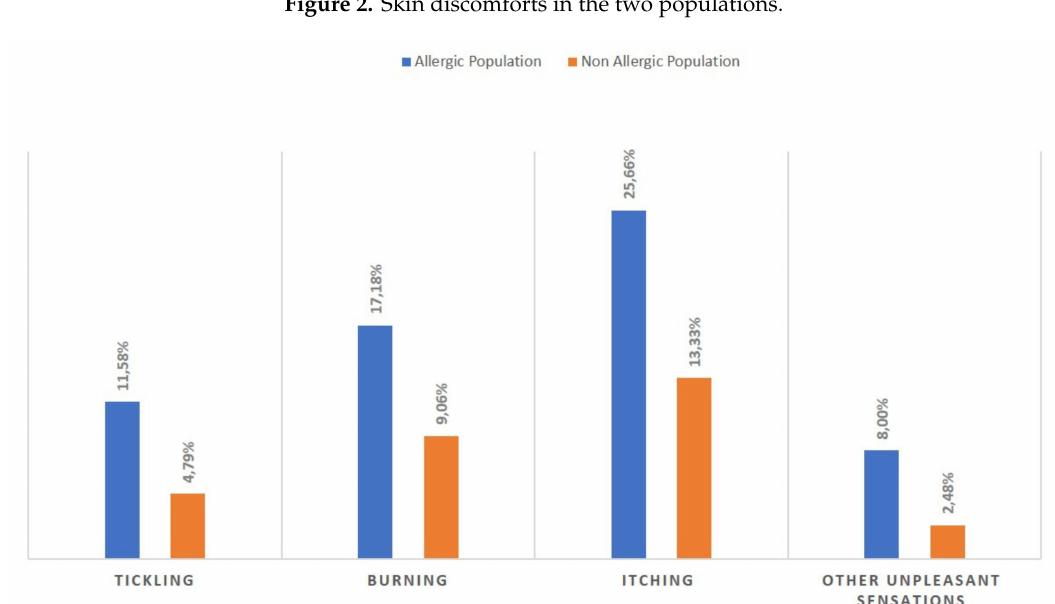
Figure 2. Skin discomforts in the two populations.